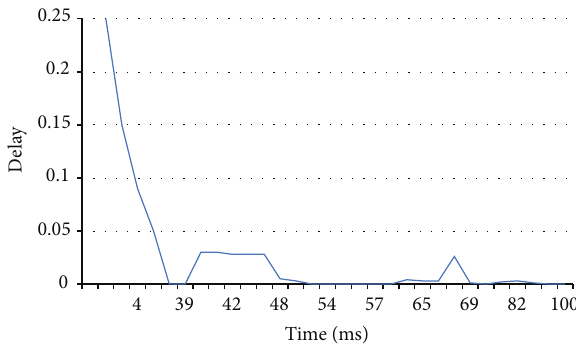
Figure 8: System delay for 16 legitimate nodes and 4 jammers.